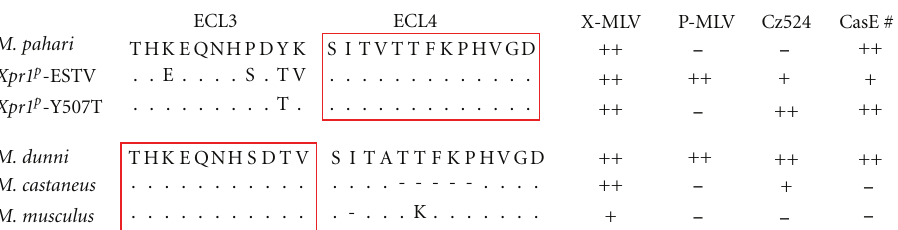
Figure 8: The entry of various XP-MLVs is a ff ected by sequence variation in ECL3 or ECL4 suggesting that these domains form a single receptor